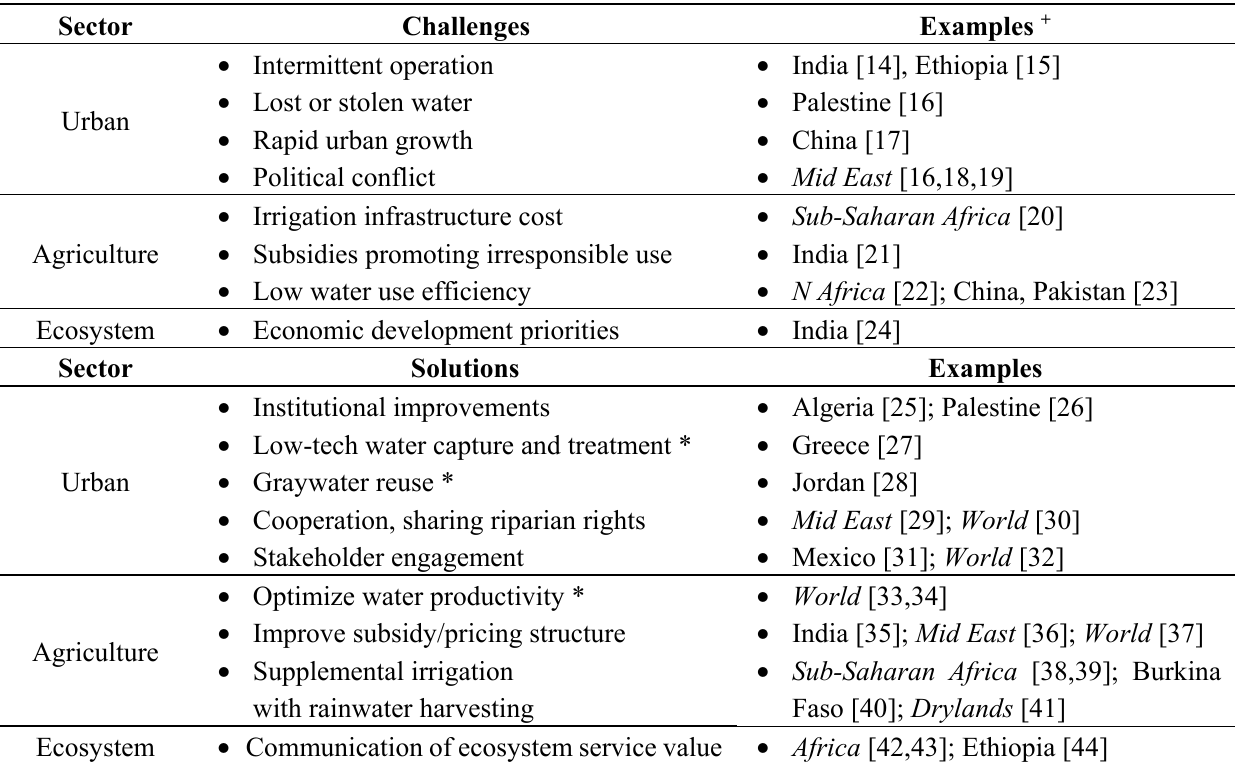
Table 3. Developing country challenges and solutions for sustainable water management in urban, agricultural, and natural